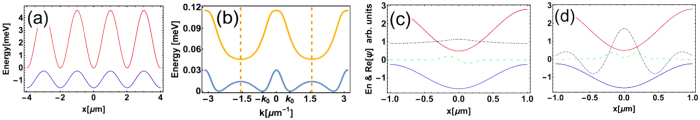
System schematic.(a) Potential profiles for QW excitons (red) and cavity photons (blue). (b) Numerically calculated dispersion of the lowest-energy EPs (blue). Orange dashed vertical lines label the edges of the first Brillouin zone. Yellow curve depicts the imaginary part of the polariton energy as a function of k. (c,d) Real part of the wave function of cavity photons (black dot-dashed) and excitons (green dashed) in a single lattice period with k = 0 (c) and k at the edge of the Brillouin zone (d).